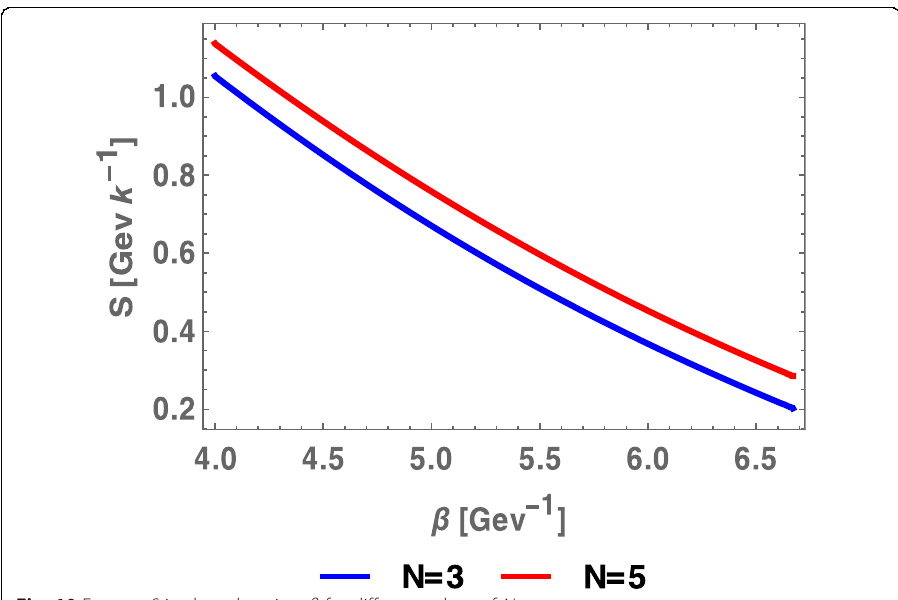
Fig. 10 Entropy S is plotted against β for different values of